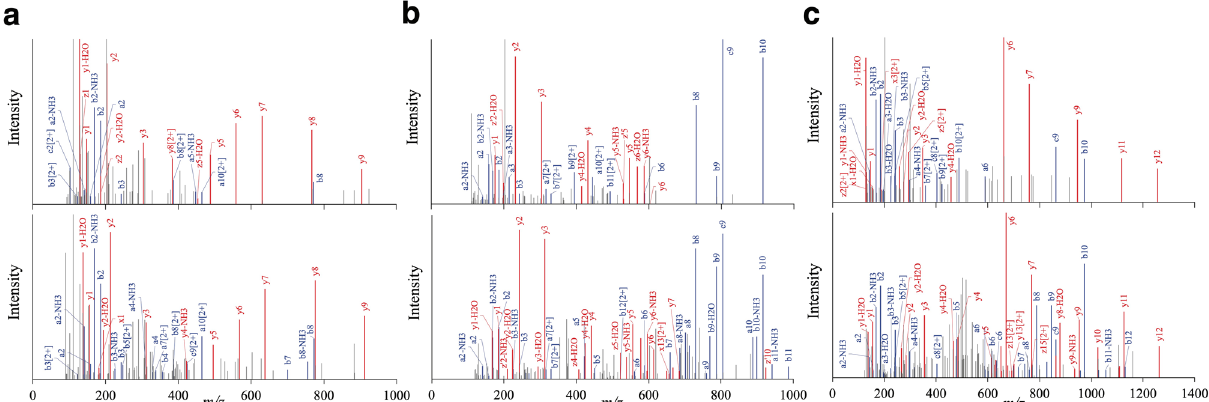
Figure 2. Annotated MS/MS fragmentation spectra for suprabasin-derived peptides filtered by peptidomic analysis and comparisons with those of corresponding stable isotope-labeled synthetic peptides. Human plasma extracted using the improved differential solubilization method was prefractionated and subjected to LC–MS/MS analysis. MS/MS spectra with sequence assignments of fragment ions corresponding to ( a ) SBSN_HUMAN[225–237] “GQGIHHAAGQVGK” with a m/z 420.5583 ( z = 3), ( b ) SBSN_HUMAN[243– 259] “GQGAHHAAGQAGNEAGR” with a m/z 397.9386 ( z = 4) and ( c ) SBSN_HUMAN[279–295] “GQGVHHTAGQVGKEAEK” with a m/z 578.2957 ( z = 3) (upper panels) are compared with those of respective stable isotope-labeled synthetic peptides (lower panels) to confirm the putative identification. MS/MS spectra were deconvoluted into singly charged ions from the observed spectra and peaks were assigned theoretical m/z values for fragment ions. The annotations of the identified matched amino terminus-containing ions are shown in blue and the carboxyl terminus-containing ions in red. The m/z differences between theoretical and observed values for most assigned peaks were less than 0.01